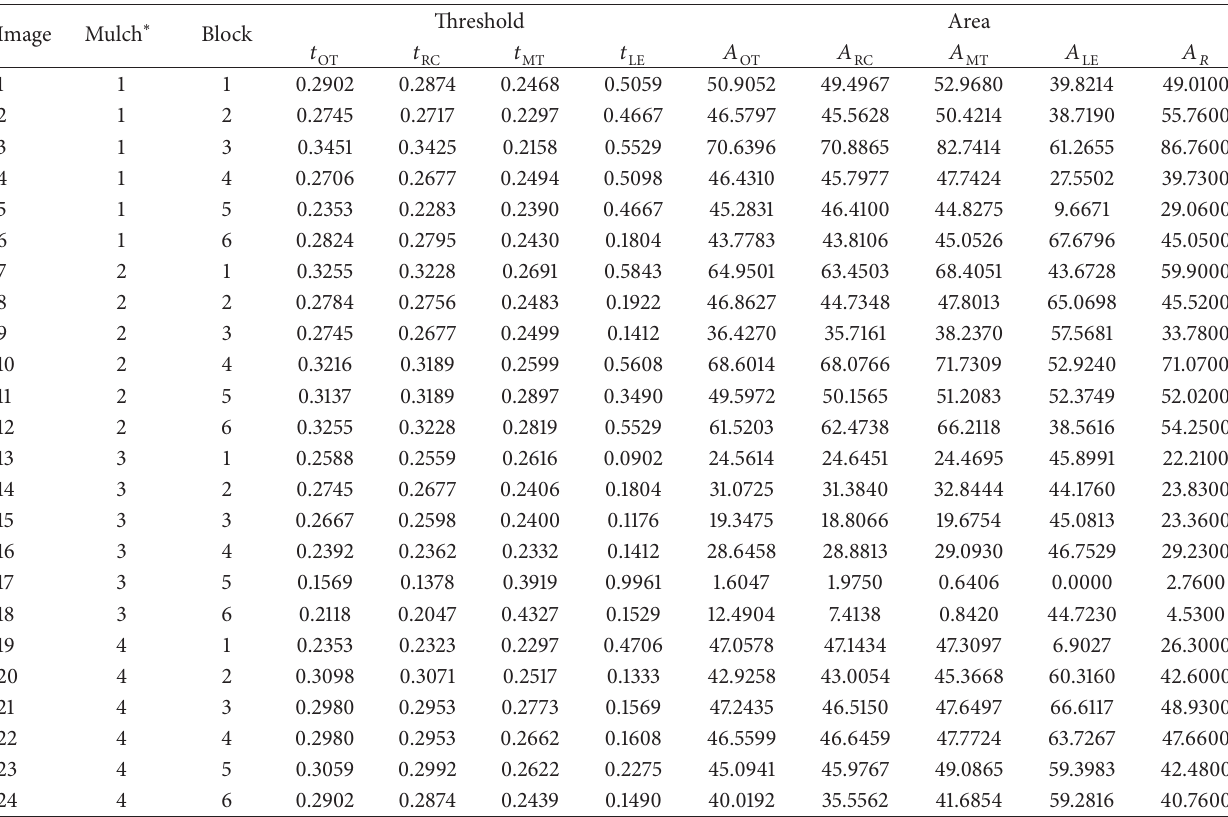
Table 1: Thresholds and areas obtained after eliminating small objects. Thresholds: Otsu ( 𝑡 ), and local entropy ( 𝑡 ( 𝑡 MT area ( 𝐴 𝑅 ).